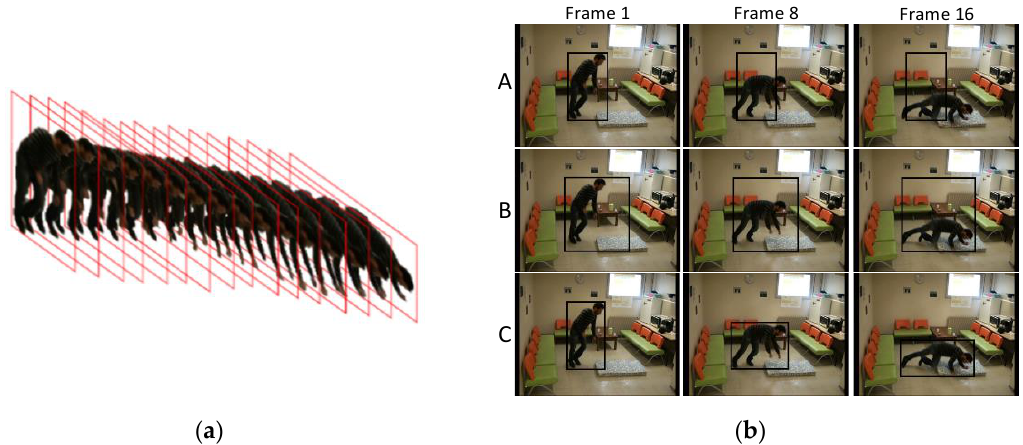
Figure 2. The constrained movement tube: ( a ) A fall person who is well constrained by a movement tube; ( b ) the comparison of three manners of bounding boxes encapsulating the person.